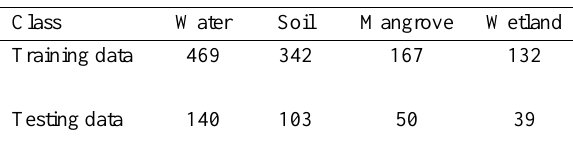
Table 3. Training and testing samples.